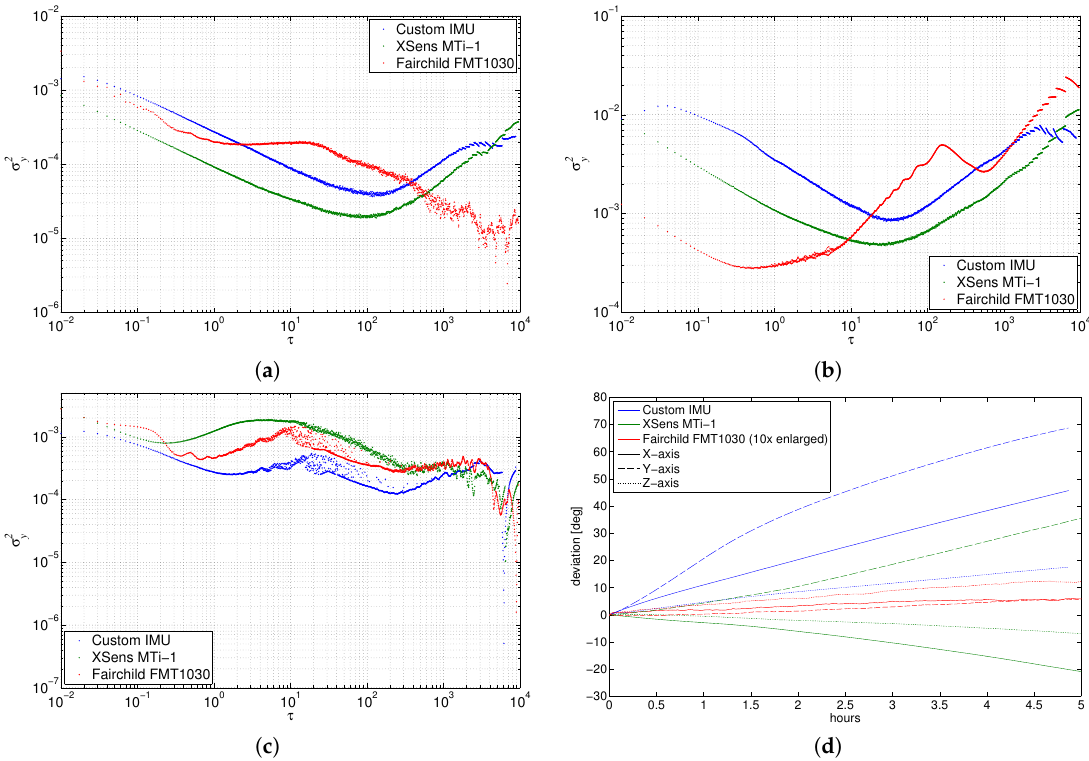
Figure 4. Static experiment results: representative Allan variances for the tested IMUs: ( a ) gyroscopes; ( b ) accelerometers; ( c ) magnetometer (for yaw axis-Z); ( d ) drift resulting from gyroscope